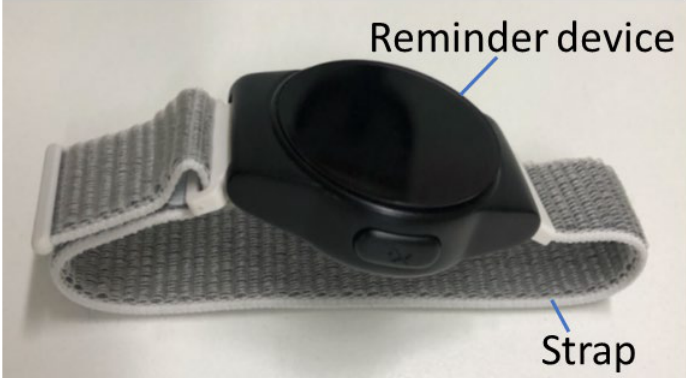
Figure 2. The foot band used in this study.